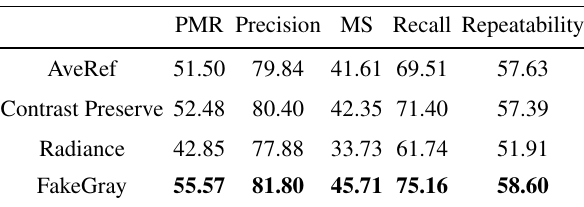
Table 4. Matching Metric for 10-stack points on rotation dataset (all data are